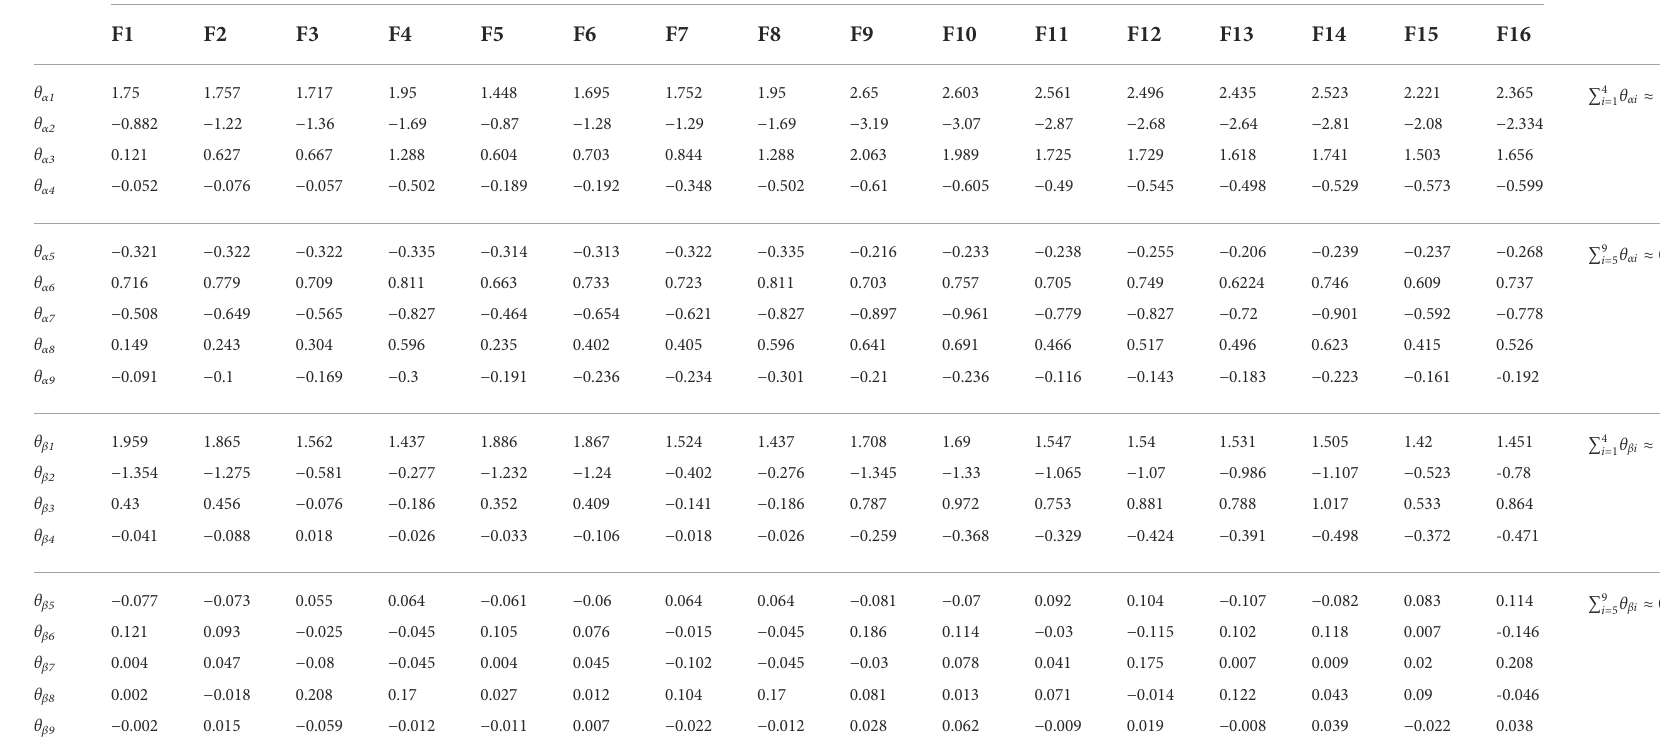
TABLE 2 GDEM parameters of the PV PGs.